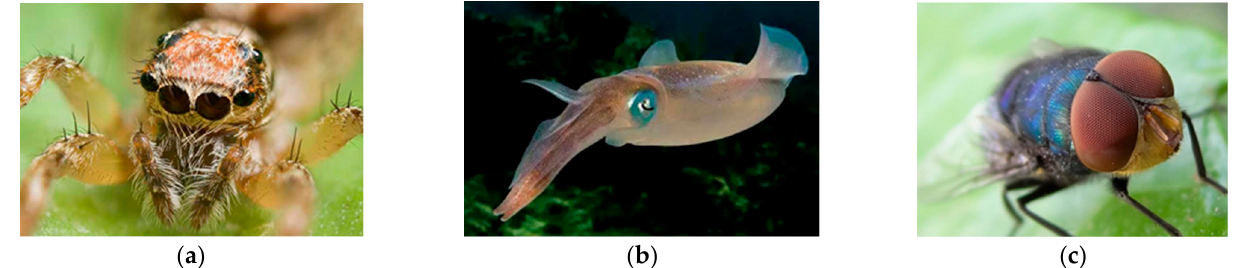
Figure 1. ( a ) The eight-eyed jumping spider with an annular compound eye structure has a 360° FOV; ( b ) Squid eyes with the ability to change their FOV. ( c ) Insect compound eye capable of detecting high-speed objects.